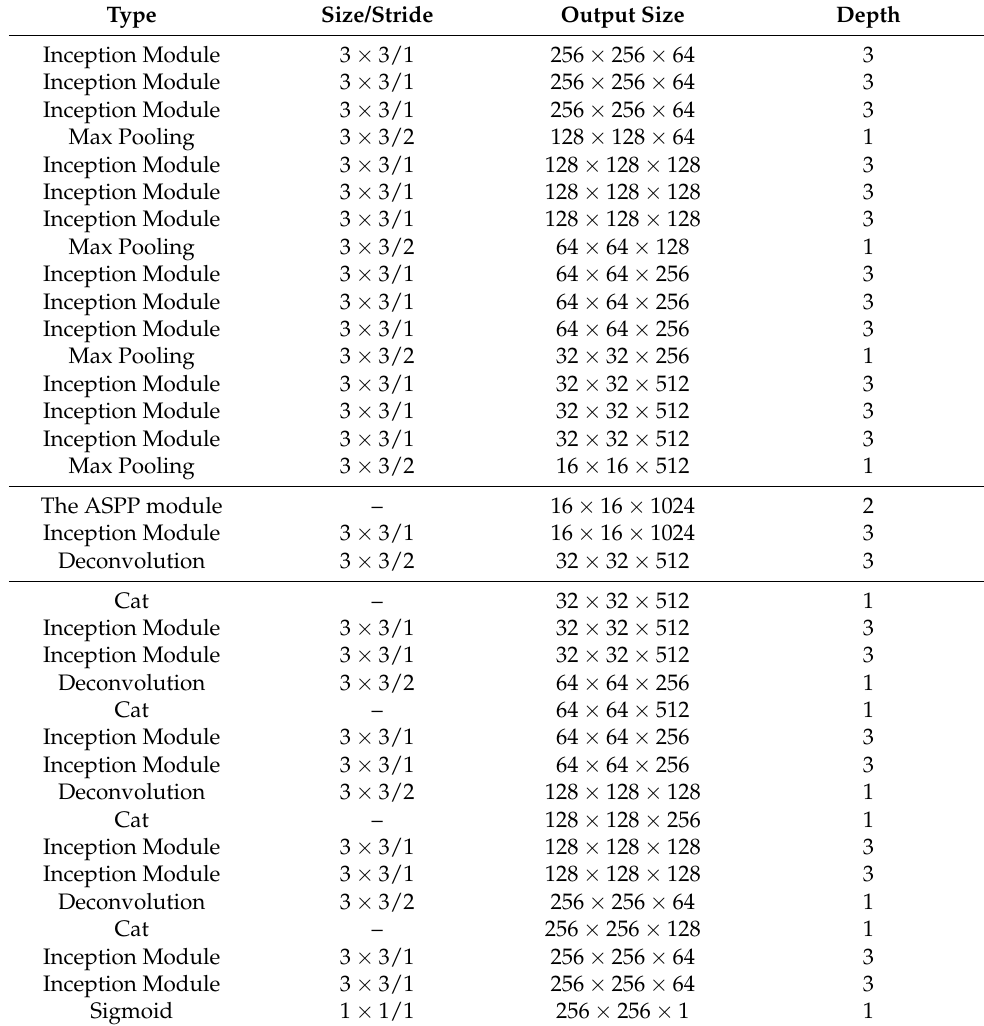
Table 1. Architecture of the proposed